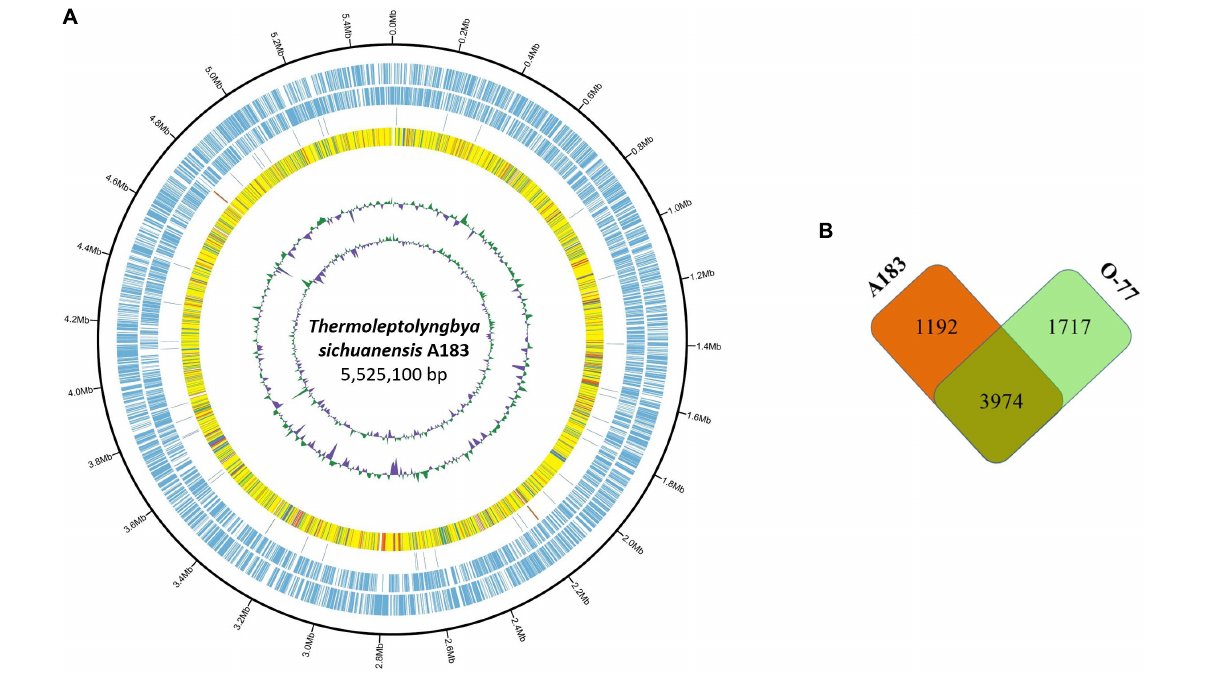
FIGURE 2 | Comparison between Thermoleptolyngbya strains. (A) Circular plot of A183 genome. Rings are as follows (outer-inner): CDS on plus strand; CDS on minus strand; rRNA (orange) and tRNA (blue); the shared amino acid identities of BLASTP alignments with O-77; the last two circles represent GC content and GC skew both calculated for a 10-kb window with 1-kb stepping. The color scheme for the heat map of orthologs is as follows: yellow, orthologs ≥ 90% identity; blue, 80–90% identity; green, 70–80% identity; red, 50–70% identity; orange, 30%–50% identity. (B) Number of shared and specific genes between